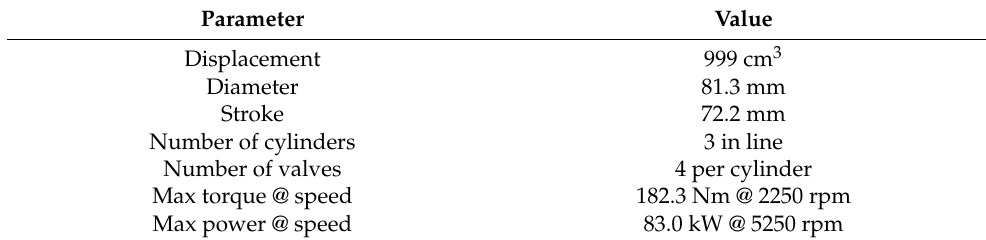
Table 1. Engine specifications used for validation of the ICE